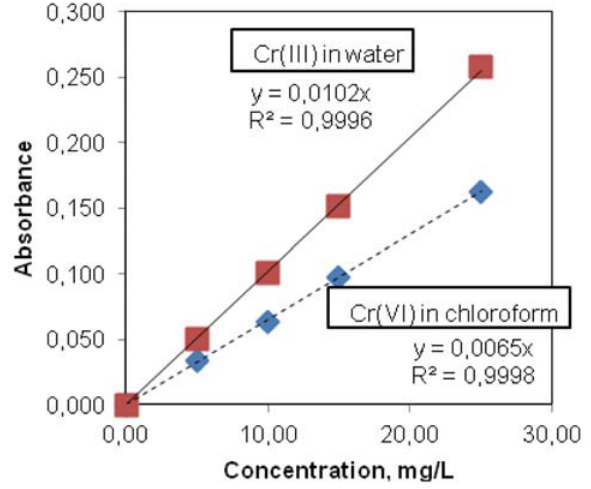
Figure 6. GFAAS calibration curve for Cr(III) in water phase and Cr(VI) in organic phase with 1 % ( w/w ) methyltrioctylammonium chloride in